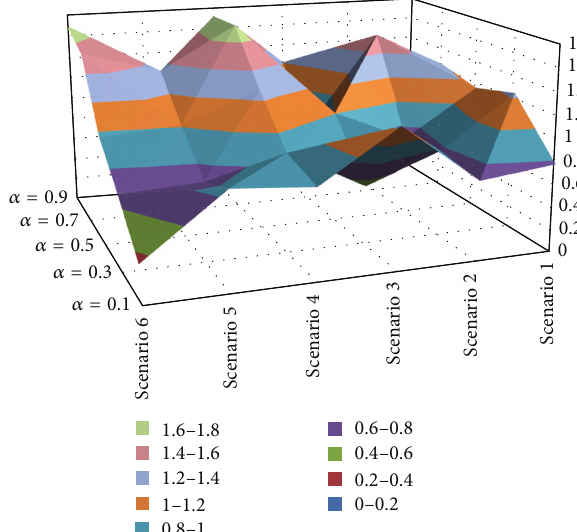
Figure 16: REP changes in different scenarios with respect to ddmfd , fd speed parameter.